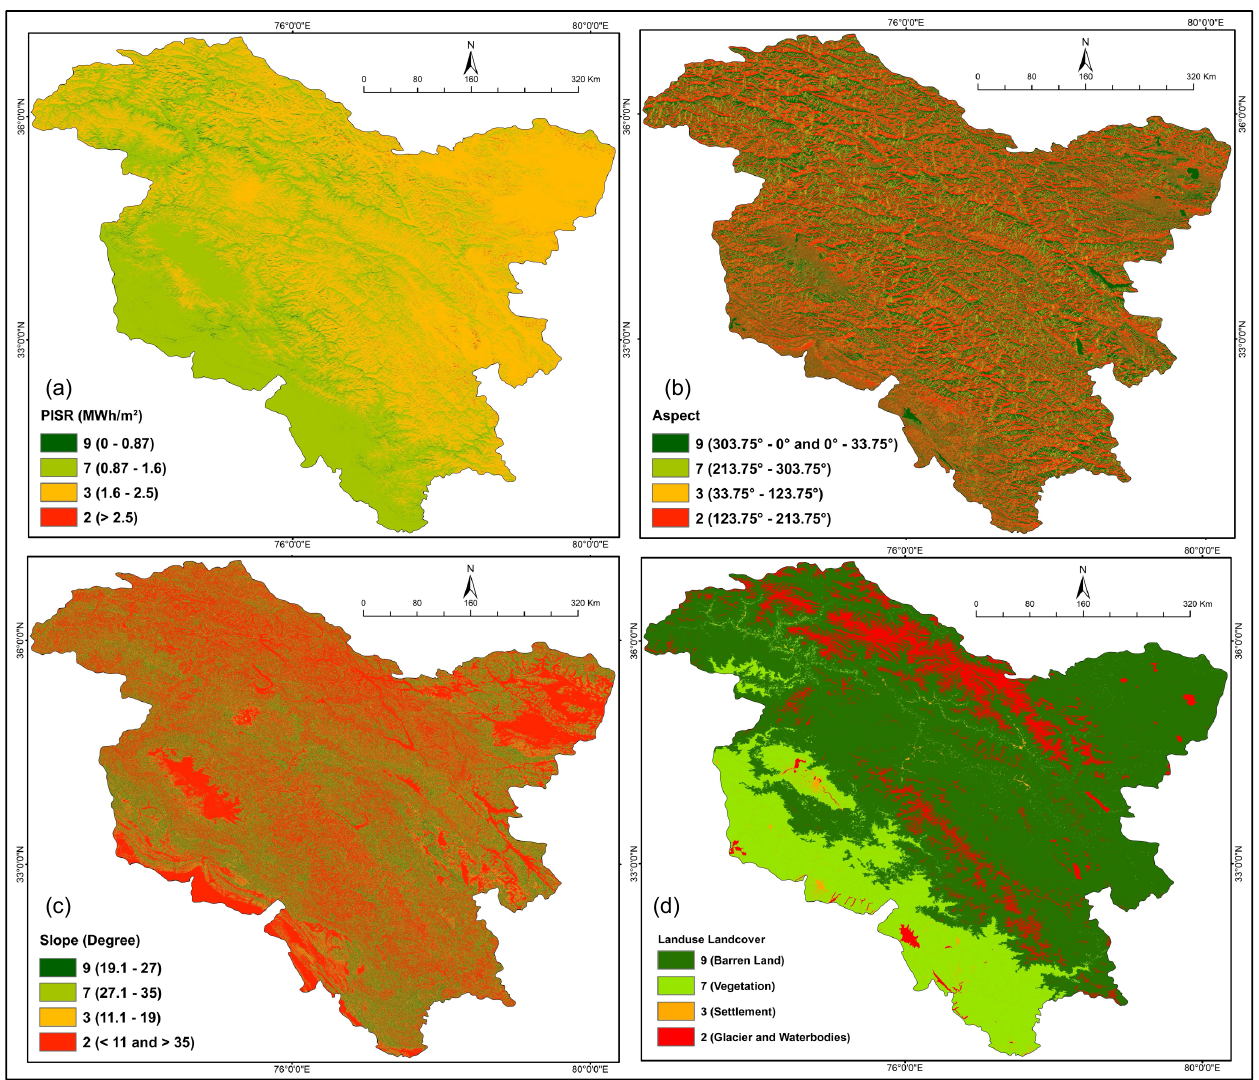
Figure 4. Maps of the study area showing the ground variables ( a ) Potential incoming solar radiation (PISR) from Shuttle Radar Topographic Mission (SRTM), ( b ) Aspect from SRTM, ( c ) Slope from SRTM, and ( d ) Land use and land cover mapped on Landsat 8, used in analytical hierarchy process (AHP).